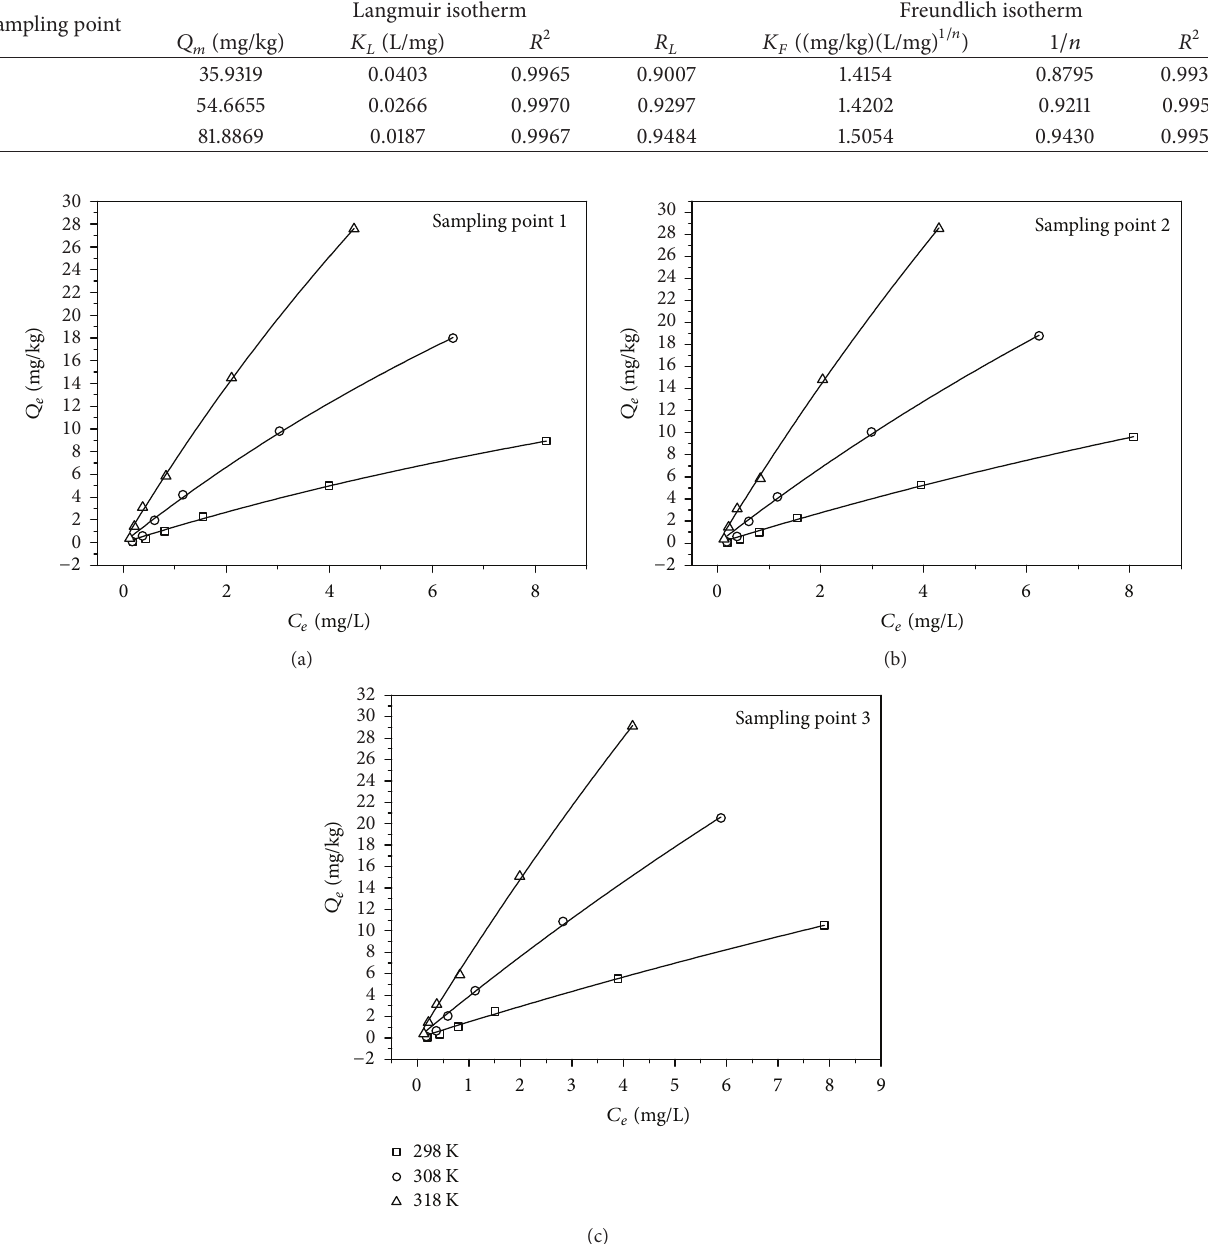
Figure 7: Langmuir fit of OTC adsorption onto sediment samples in different